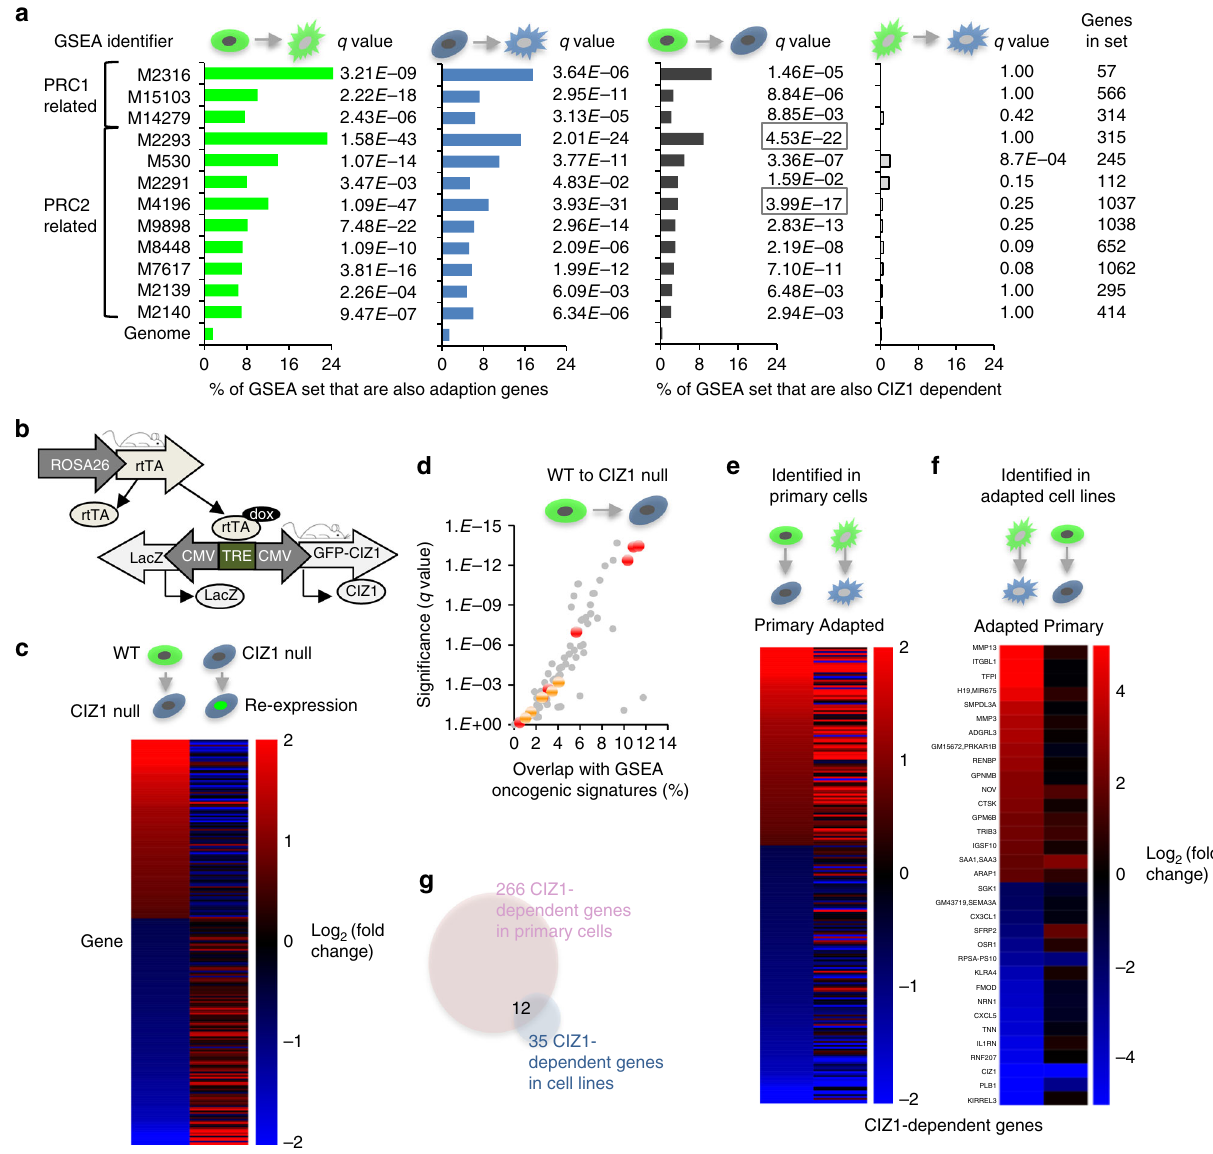
Fig. 3 Relaxation of polycomb-regulated gene expression. a Relationship between affected transcription units ( q < 0.05, cuffdiff) in Fig. 2 and PRC1 or PRC2-related curated gene sets (GSEA MSigDB 22 ), with signi fi cance expressed as q value. Set identi fi ers and number of genes in sets are indicated. Overlap with genes affected by culture adaption of WT cells (green) and CIZ1-null cells (blue). Overlap with CIZ1-dependent genes in primary cells (dark grey) and culture-adapted cells (light grey). b Schematic of transgenes used to create doxycycline-inducible expression of full-length GFP-CIZ1 in CIZ1 null mice and derived cells 5 . c Heat map showing 266 transcription units ( q < 0.05, cuffdiff) affected by the loss of CIZ1 in primary cells, organised by fold- change. Right column, mean fold change in the same transcription units in CIZ1 null cells (13.17 p3, 14.19p1), 24 h after induction of full-length CIZ1 5 (Supplementary data 4, sheet 2). d Relationship between CIZ1-dependent transcription units in primary cells ( q < 0.05, cuffdiff) and all 189 oncogenic signatures (GSEA MSigDB 22 ), showing overlap (% of genes that are affected by the loss of CIZ1) against signi fi cance. Grey dots indicate oncogenic signatures not related to PRC 1 or 2. Red, sets that are up-regulated when a PRC subunit is down-regulated, or vice versa. Yellow, sets that are upregulated when a PRC subunit is upregulated or vice versa. e Heat map showing fold-change in 266 CIZ1-dependent transcription units ( q < 0.05, cuffdiff) in primary cells (left, same as Fig. 1c), compared to fold-change in the same genes in culture-adapted derivatives, upon loss of CIZ1 (right). Supplementary data 4, sheet 3. f Heat map showing the 35 transcription units that are CIZ1-dependent in adapted cells ( q < 0.05, cuffdiff) (left), and fold change in these transcription units in primary cells (right). Supplementary data 5. g Venn diagram showing overlap between transcription units that are differentially expressed upon loss of CIZ1 in primary and derived lines. Highlighted in Supplementary data 5. All q values (false detection rate corrected P values) for overlap with GSEA MSigDB were calculated using one-sided Fisher ’ s Exact tests with Benjamini – Hochberg false discovery rate correction. Heat maps